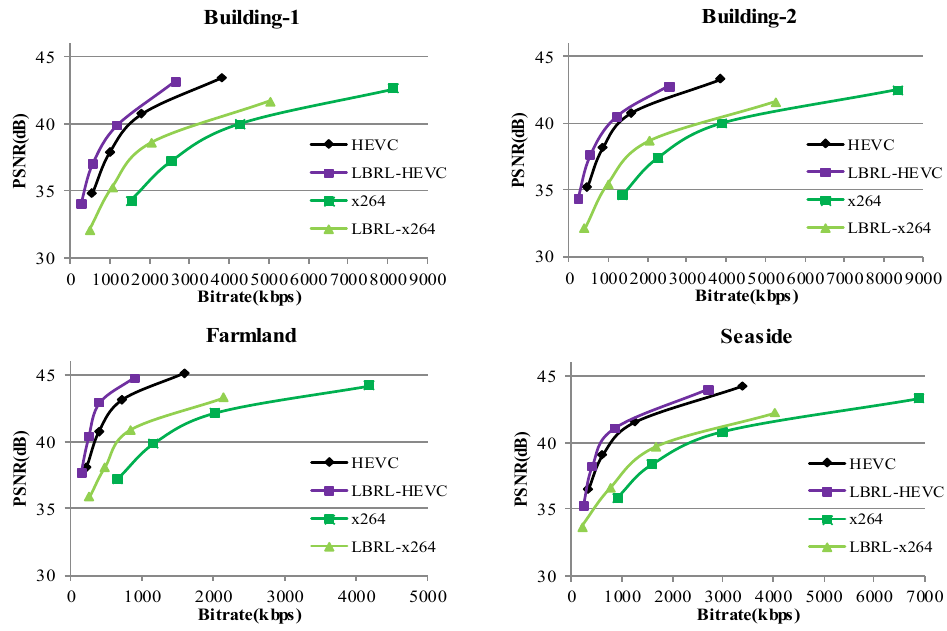
Figure 10. RD curves of LBRL-x264 , x264 , LBRL-HEVC , and HEVC from four satellite video clips.